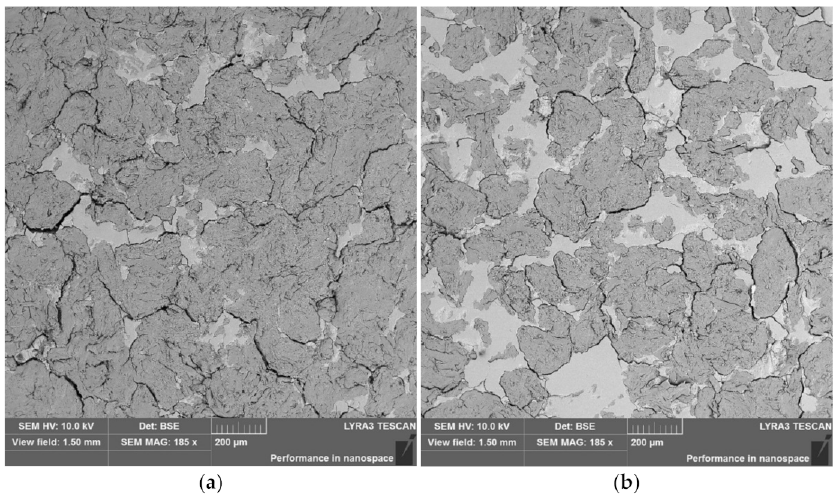
Figure 2. SEM/BSE images of cross-section of tablet compressed from mixture of microcrystalline